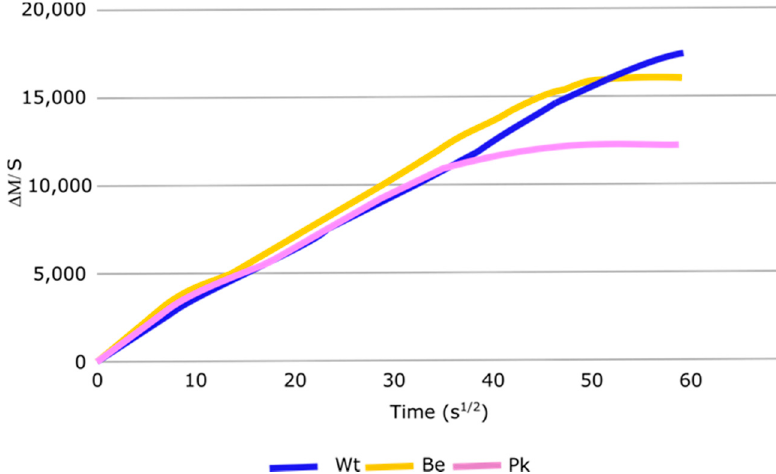
Figure 8. Time-dependent capillary water.